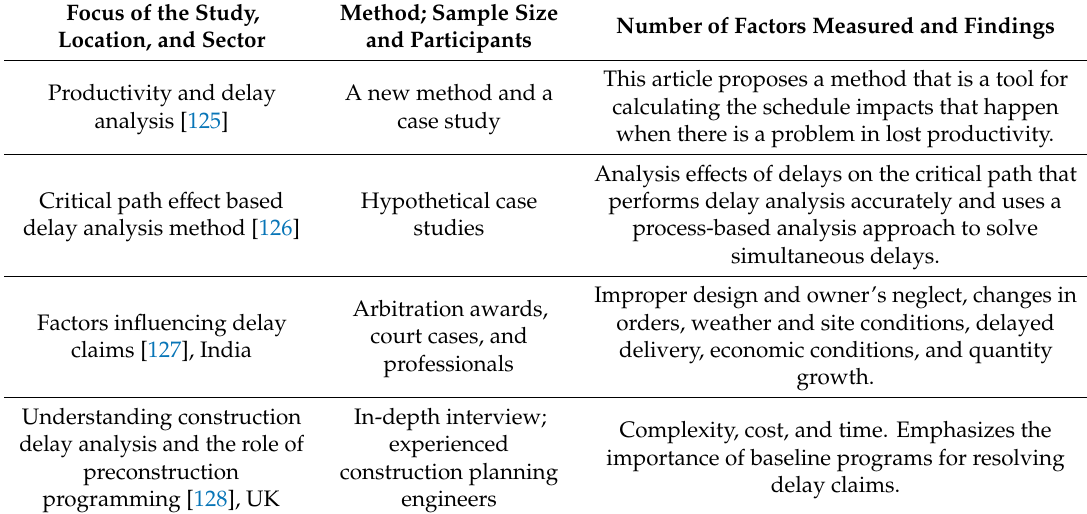
Table 5. Summary of selected articles of cluster 3 of delay investigations from 2015 to